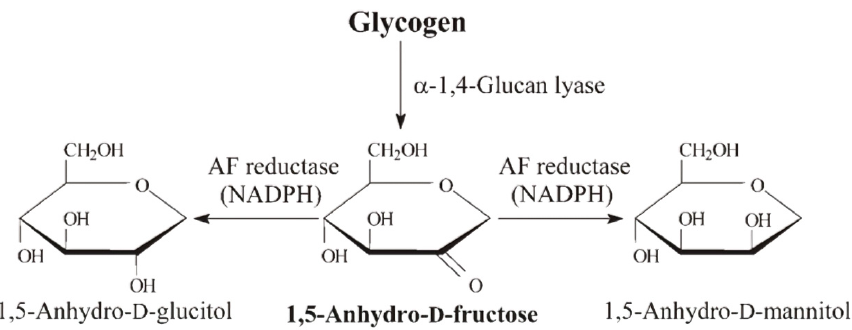
Figure 1. Chemical structure of 1,5-AF and related enzymatic reactions. 1,5-AF, 1,5-anhydro-D-fructose.